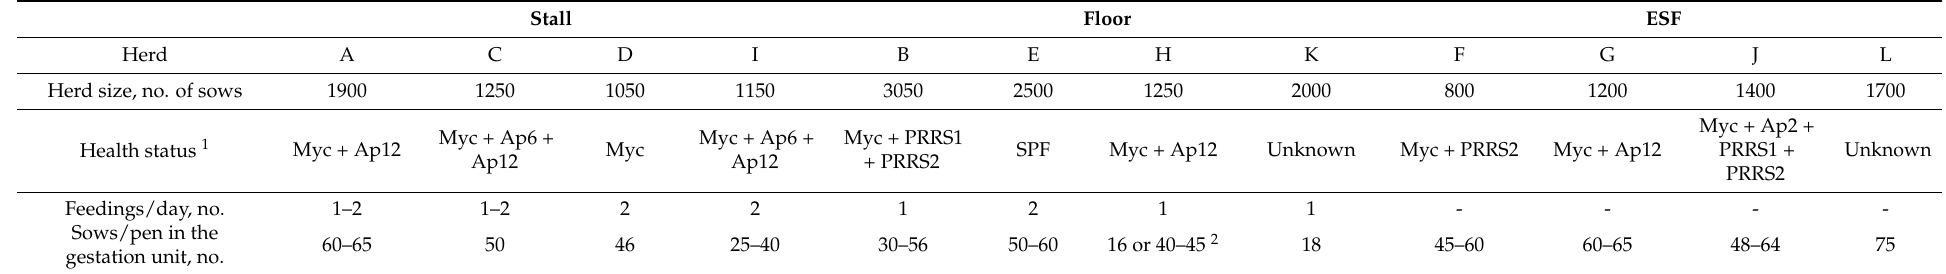
Table 1. Number of feedings per day and sows per pen in the gestation unit for the individual herds (A–L) with free-access feeding stalls (Stall), floor feeding (Floor), and electronic sow feeding